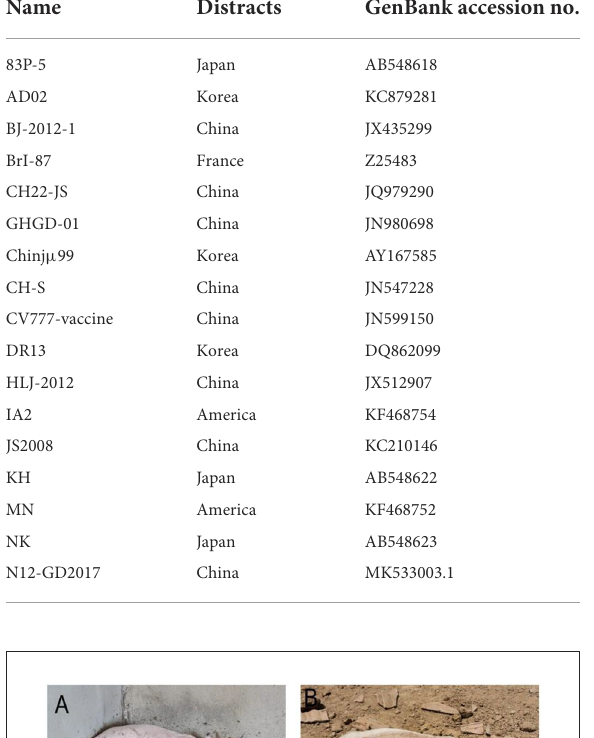
TABLE 2 Reference strain information.